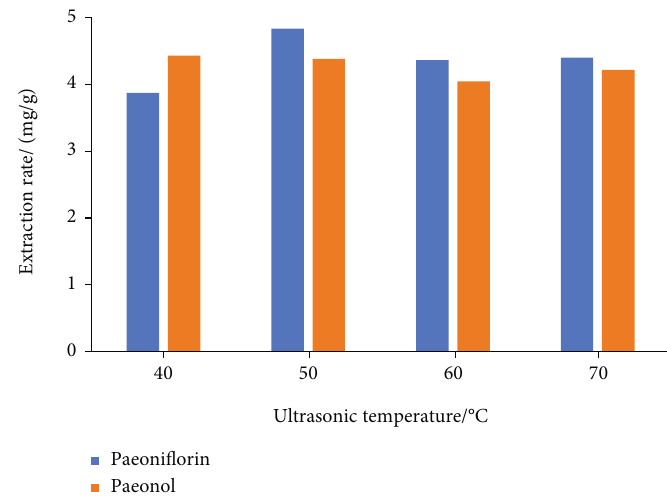
Figure 7: E ff ect of ultrasonic temperature on Moutan Cortex extraction e ffi